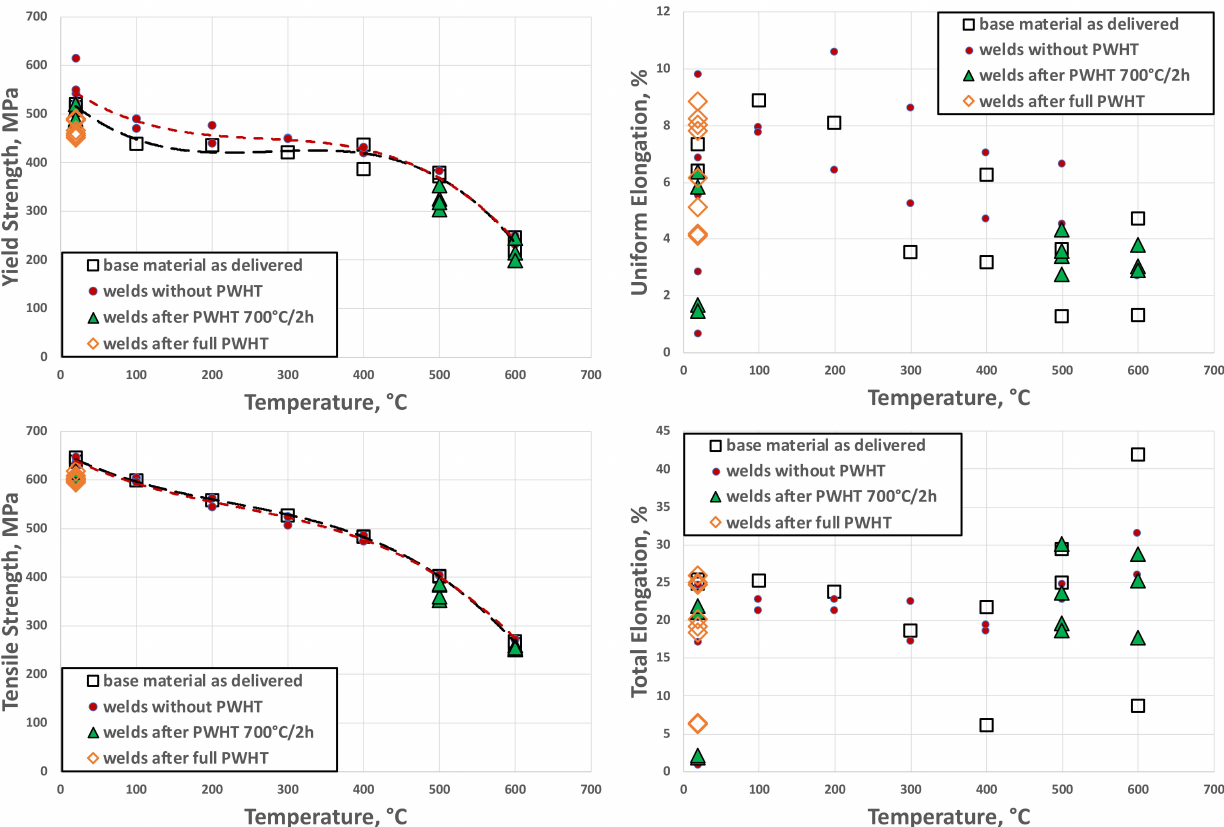
Figure 19. Tensile properties of the EUROFER base material in the condition as delivered (squares) and of the different welds without and with two different PWHTs. The different welds are not discerned. They include 5-, 10-, and 12-mm EB, laser, and TIG welds, as described in the previous